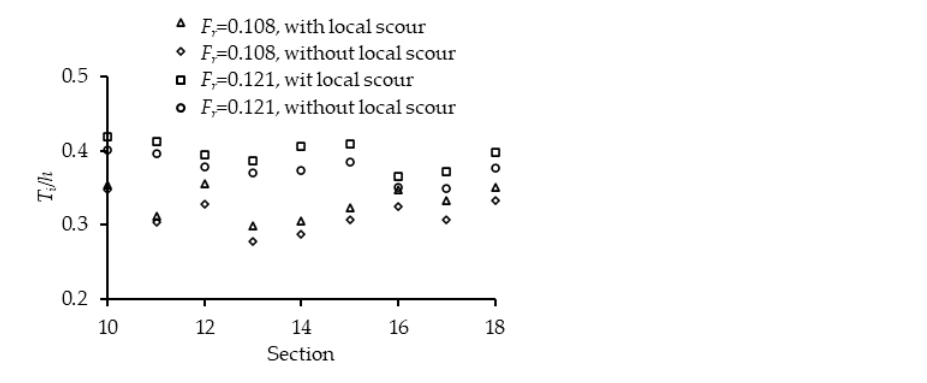
Figure 14. The ratio Ti / h at different cross sections with and without a local scour with the same F r.